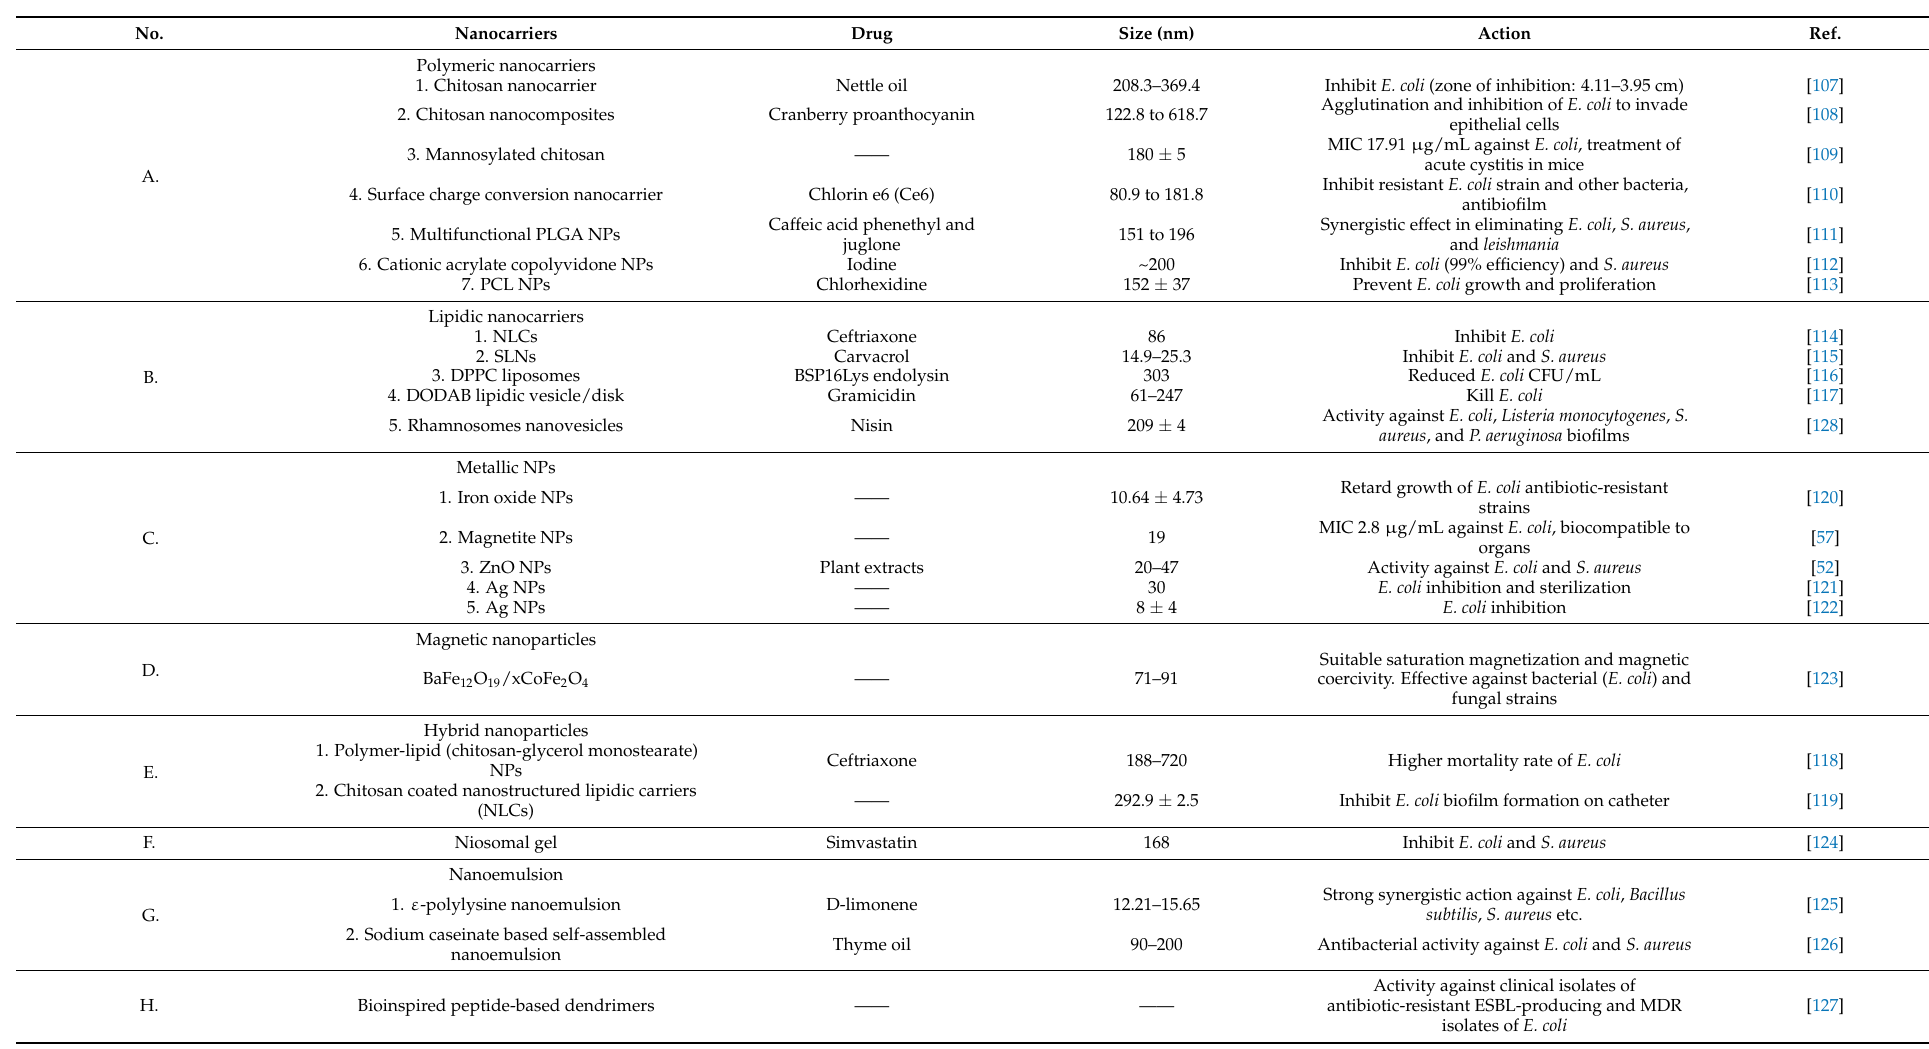
Table 2. Different types of nanocarriers for mediating anti-bacterial action against E.